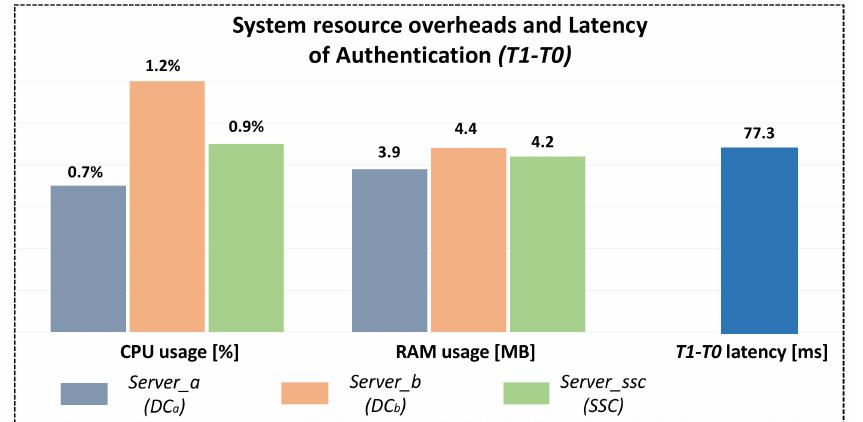
Figure 11. Latency and system resource overheads of the designed authentication